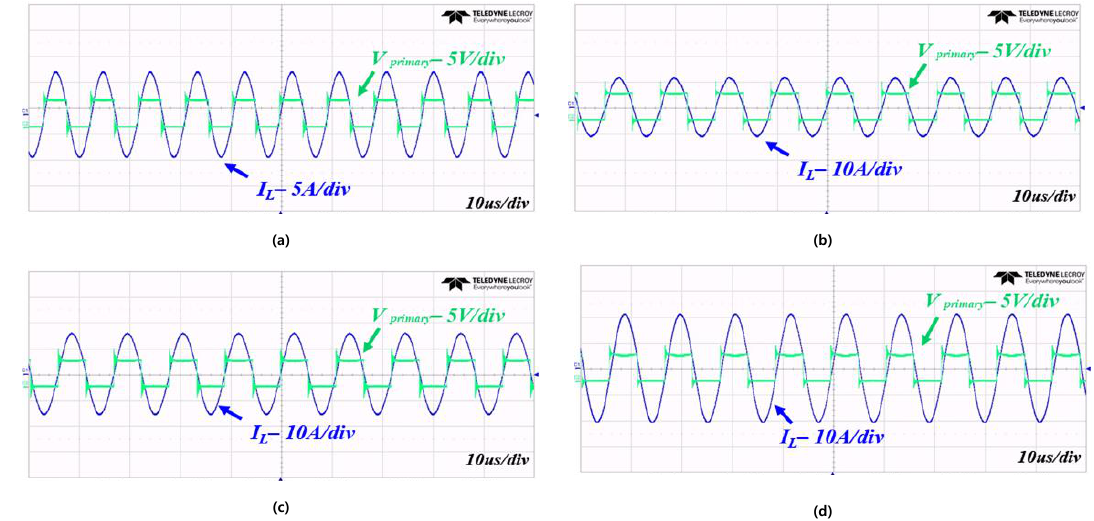
Figure 16. Wave of primary voltage and current; ( a ) d = 5 cm, Ro = 20 ohm; ( b ) d = 8 cm, Ro = 20 ohm; ( c ) d = 9 cm, Ro = 20 ohm; ( d ) d = 10 cm, Ro = 20 ohm.